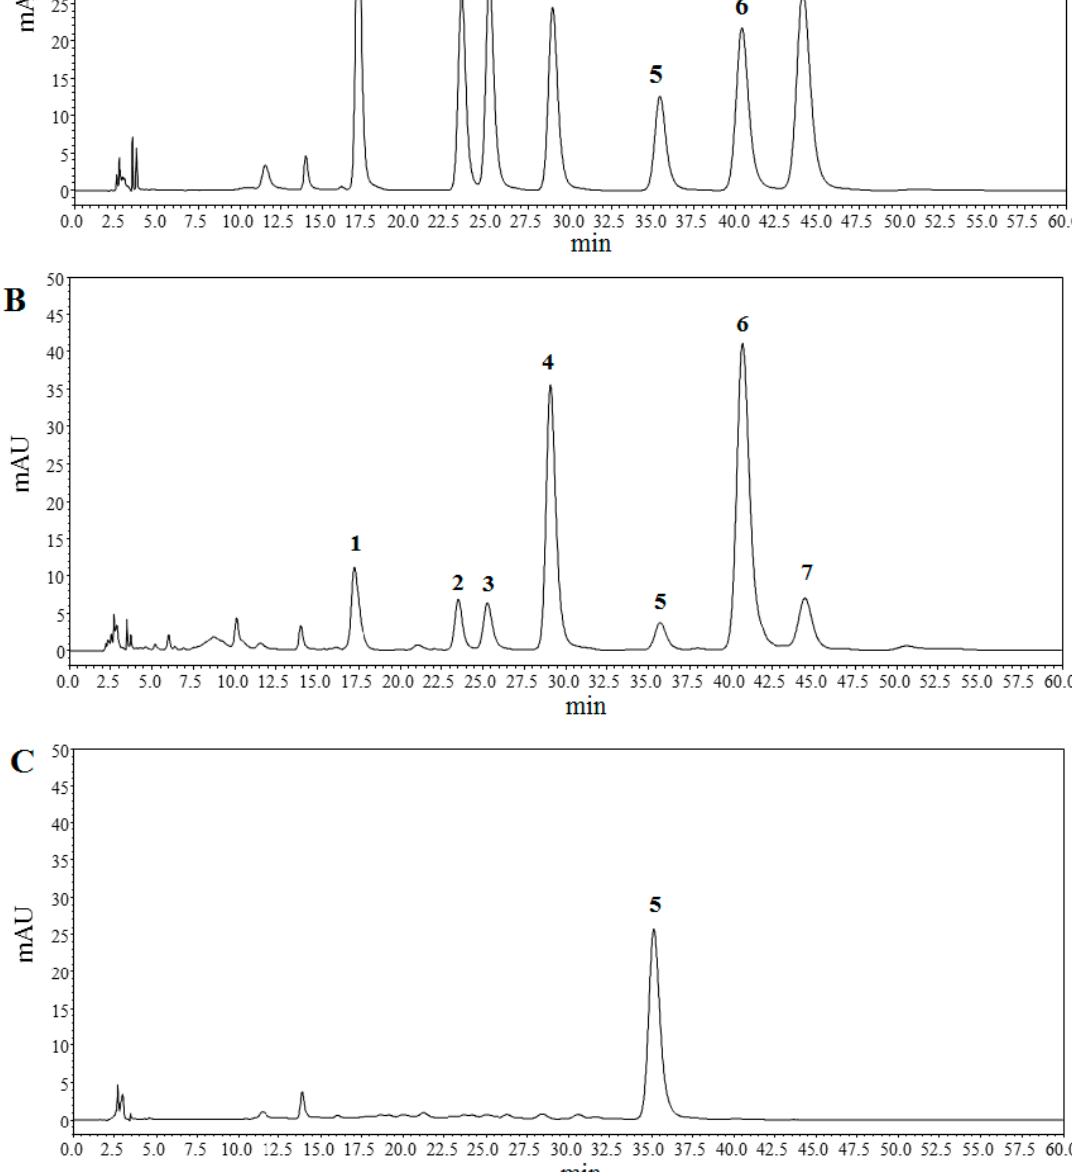
Figure 6. High performance liquid chromatography (HPLC) chromatograms of hydrolyzed polysaccharide derivatives. ( A ) is HPLC chromatogram of monosaccharide standards. ( B ) and ( C ) are HPLC chromatograms of acidic fraction of total polysaccharides-II (TPA-II) and neutral fraction of total polysaccharides-II (TPN-II), respectively. (1) mannose (Man), (2) rhamnose (Rha), (3) glucuronic acid (GluA), (4) galacturonic acid (GalA), (5) glucose (Glu), (6) galactose (Gal), (7) arabinose (Ara).